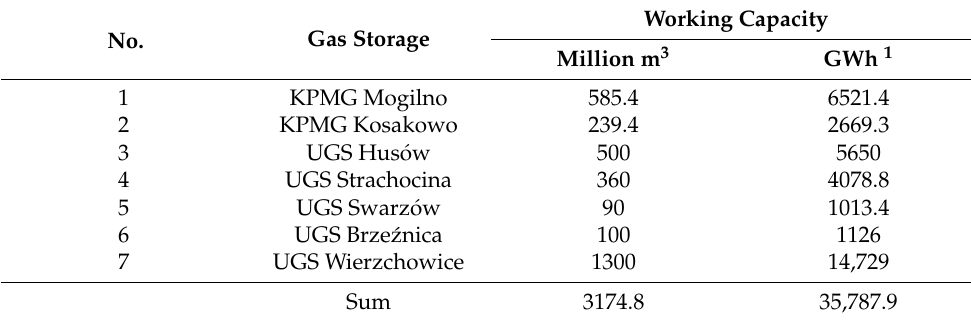
Table 2. Underground gas storage in Poland [41].